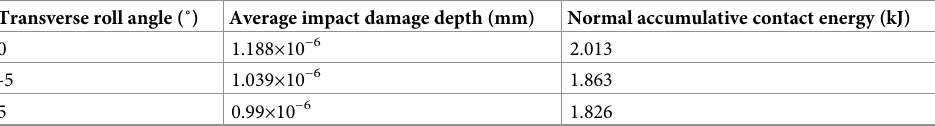
Table 6. Simulation results of the impact damage to the middle plate under the different transverse roll angles.